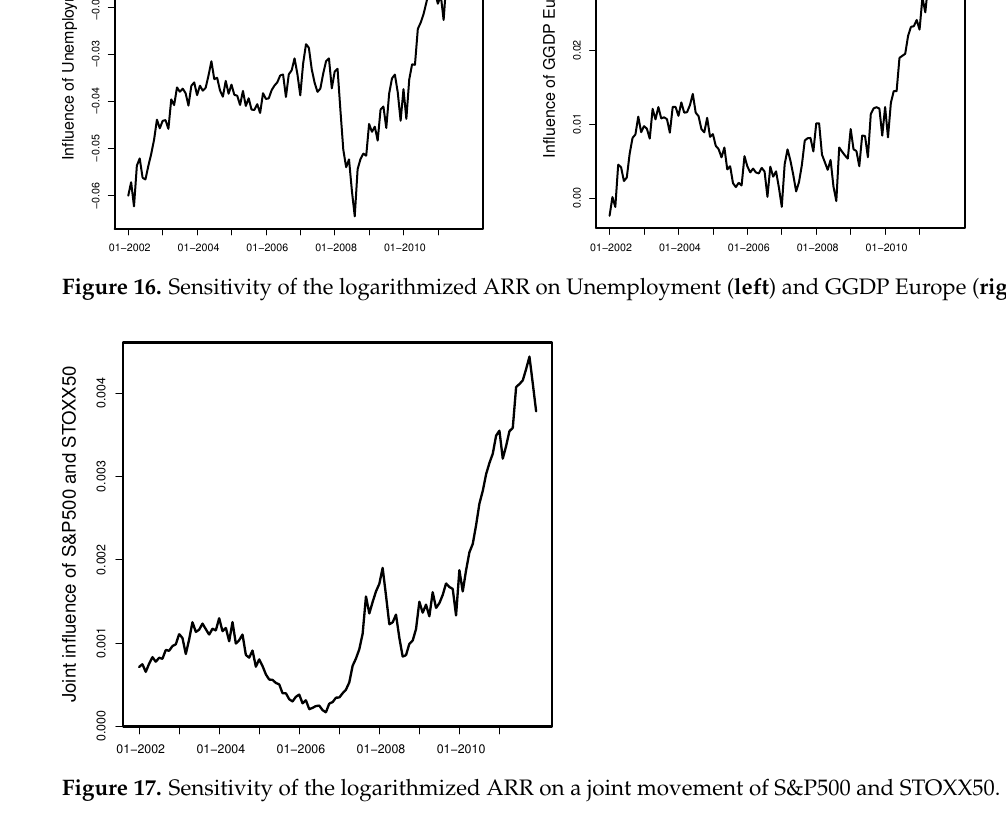
Figure 18. The obtained prediction intervals are tighter than ones for Model (6). Only 1 observation out of 144 (0.69%) falls out of them, which indicates a higher